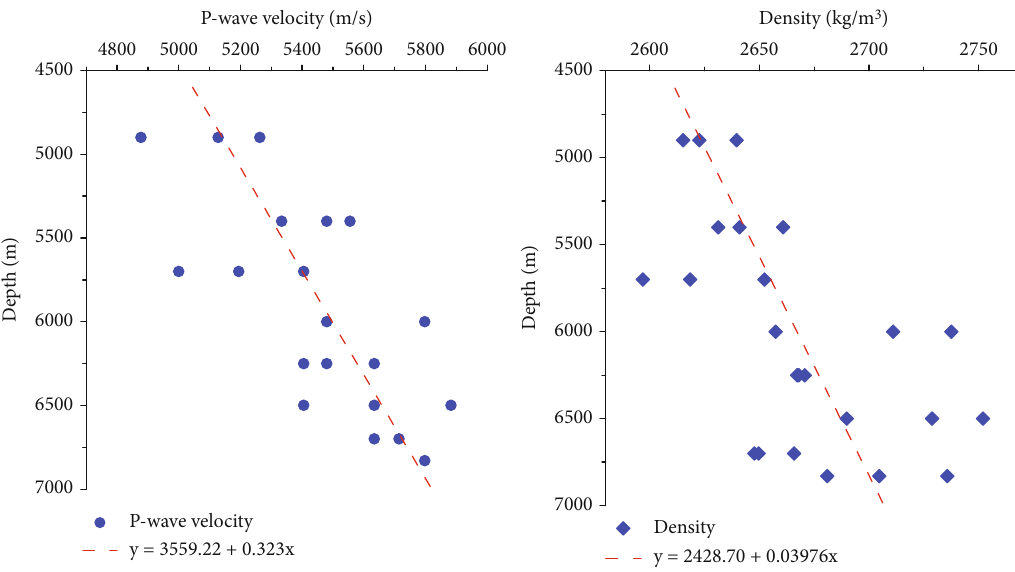
Figure 6: Variation of P -wave velocity and density with depth of cores at di ff erent depths.